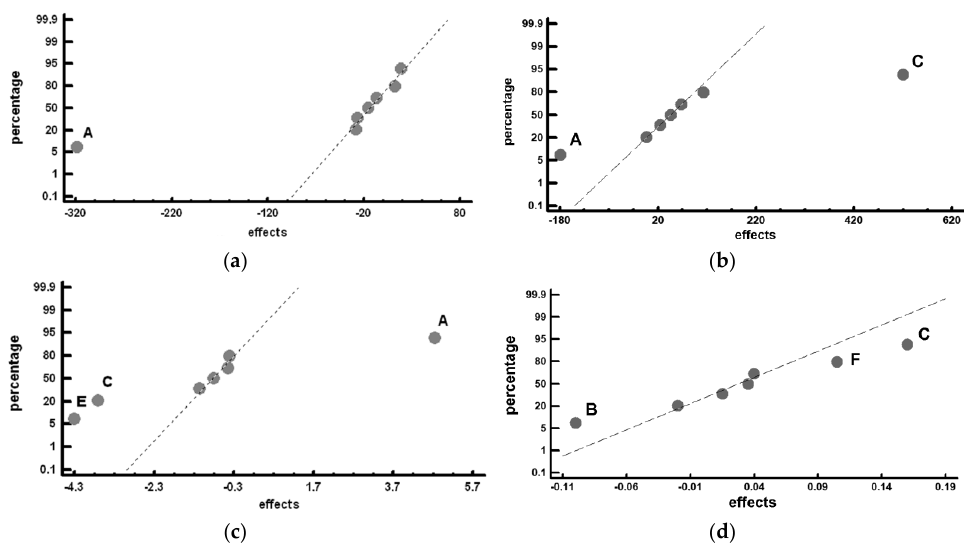
Figure 3. Representation of the effects on a normal probability plot. ( a ) measured hardness before the nitriding treatment; ( b ) measured hardness including the nitriding treatment in Experiments 5 to 8; ( c ) weight loss after the wear tests; ( d ) coefficient of friction in the wear test.